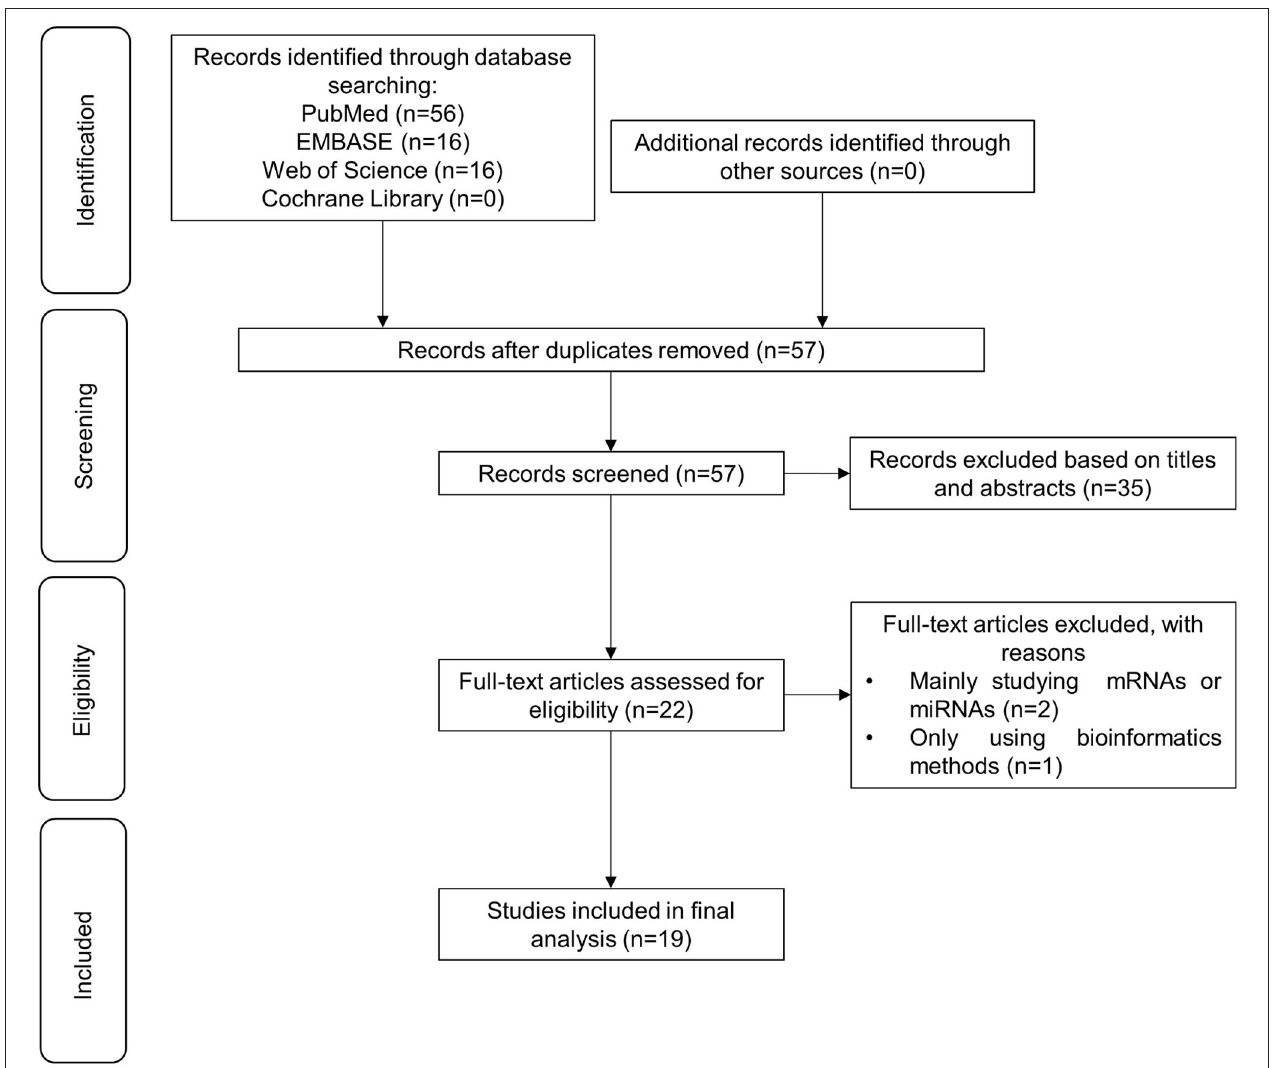
FIGURE 2 | Flow chart depicting the selection process of 16 studies included in this systematic